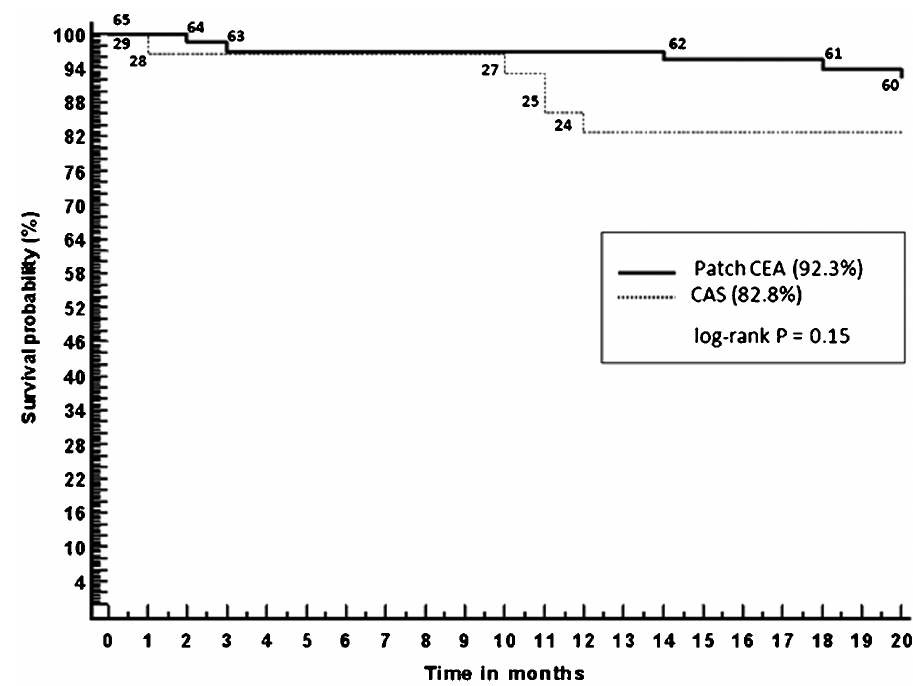
Figure 3 – Kaplan-Meier survival curves. The survival probability at 20 months was 82.8% among patients who received stent (n = 29) versus 92.3% among those who underwent patch closure (n = 65) ( P = 0.15, 95%CI = 0.0949 to 1.4458). Numbers on the graphed lines indicate the number of patients. CAS: carotid artery stenting; CEA: carotid